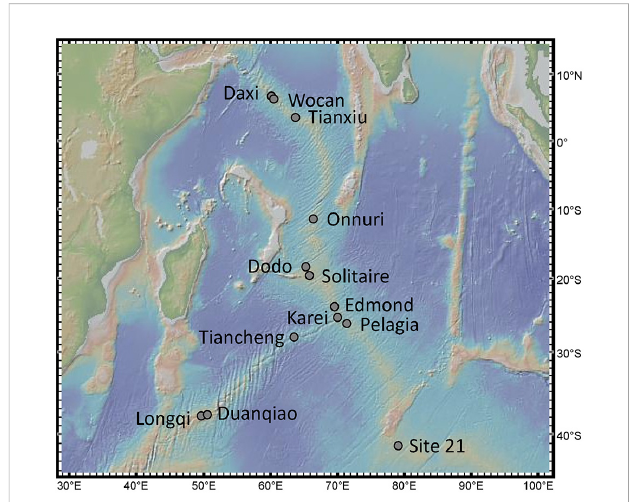
FIGURE 1 Location of the 13 active con fi rmed hydrothermal vent fi elds in the Indian ocean. Map created with